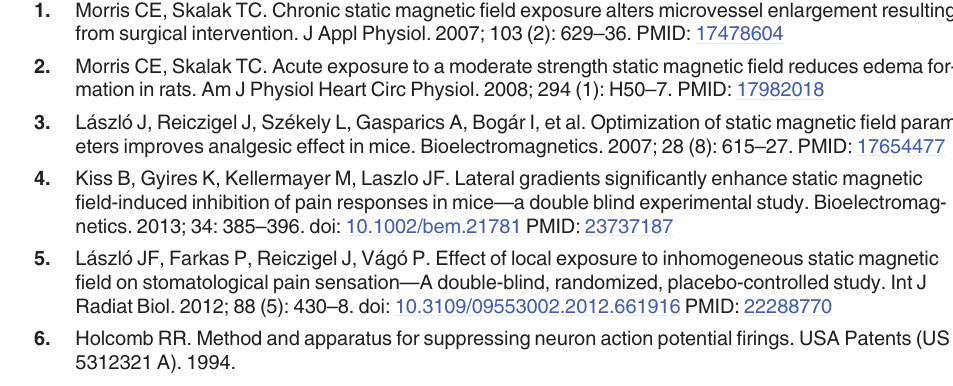
S1 Table. The table provides raw, untransformed data of ear thickness values, biometric pa- rameters and exposure conditions for individual